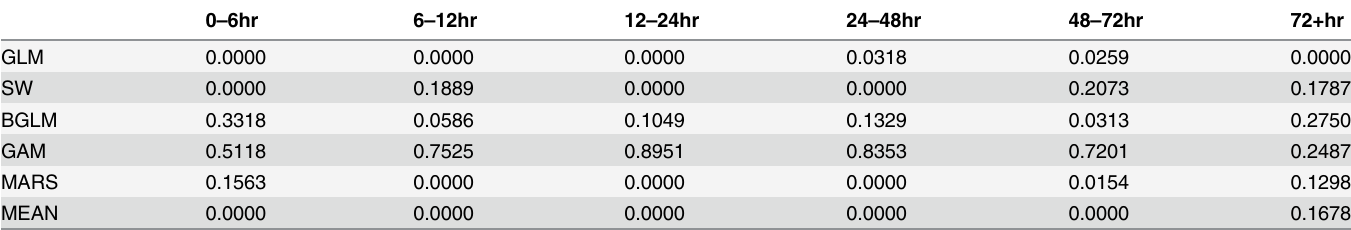
Table 1. Coefficients in the Super Learner.